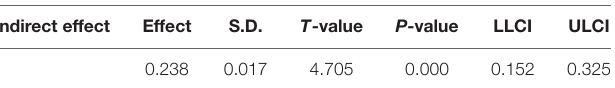
TABLE 7 | Indirect effect.